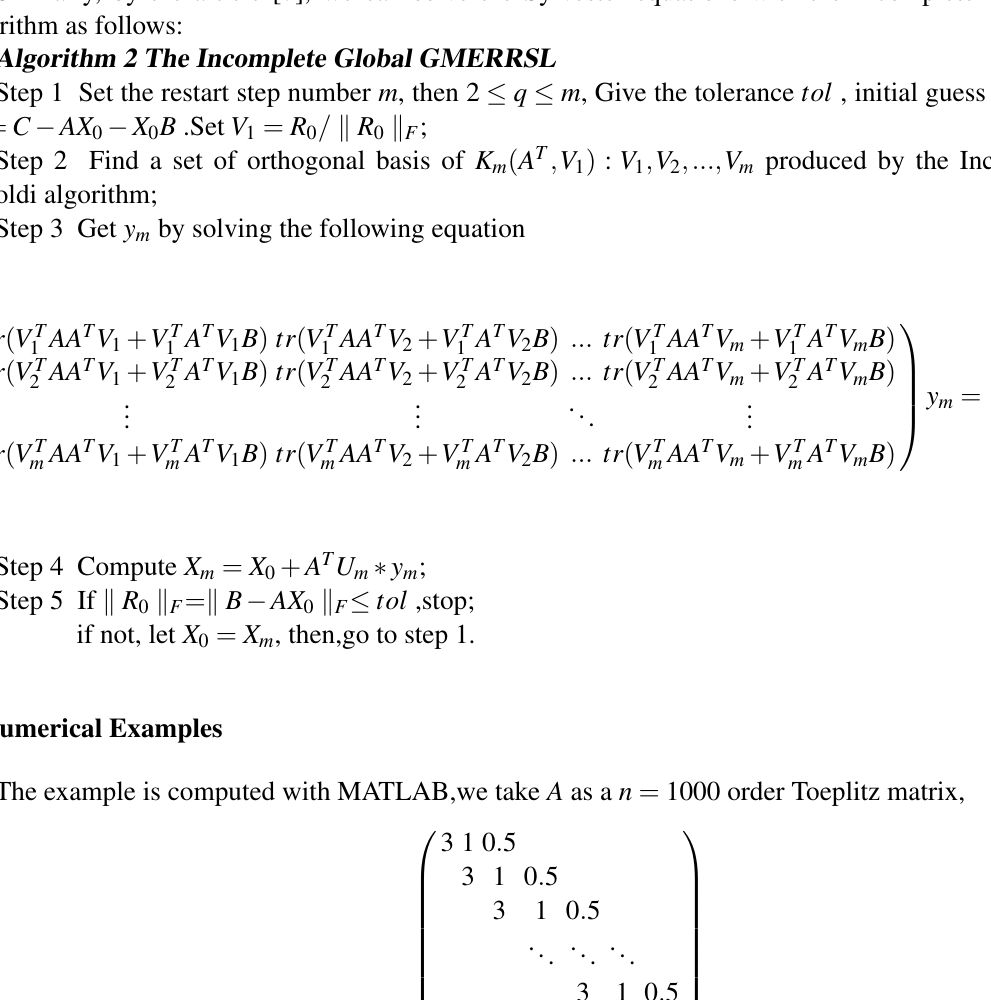
Algorithm 2 The Incomplete Global